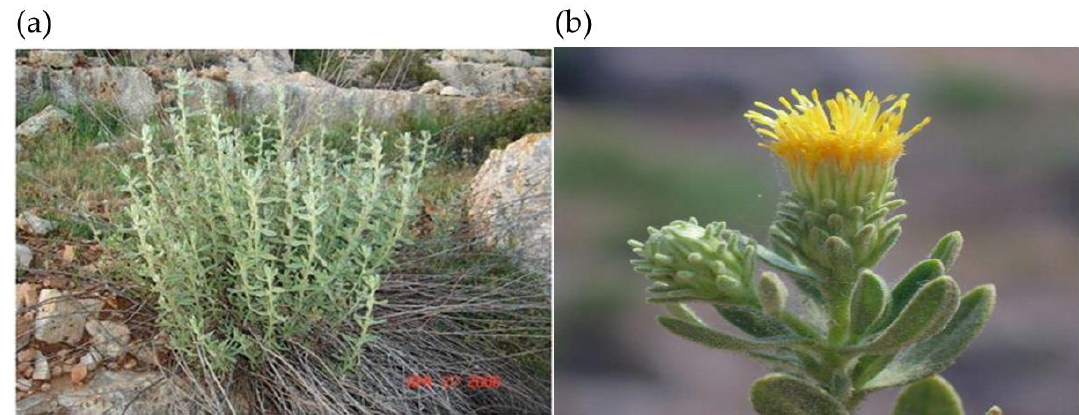
Figure 1. ( a ) Verthimia iphionoides plant and ( b ) flower of the Verthimia iphionoides